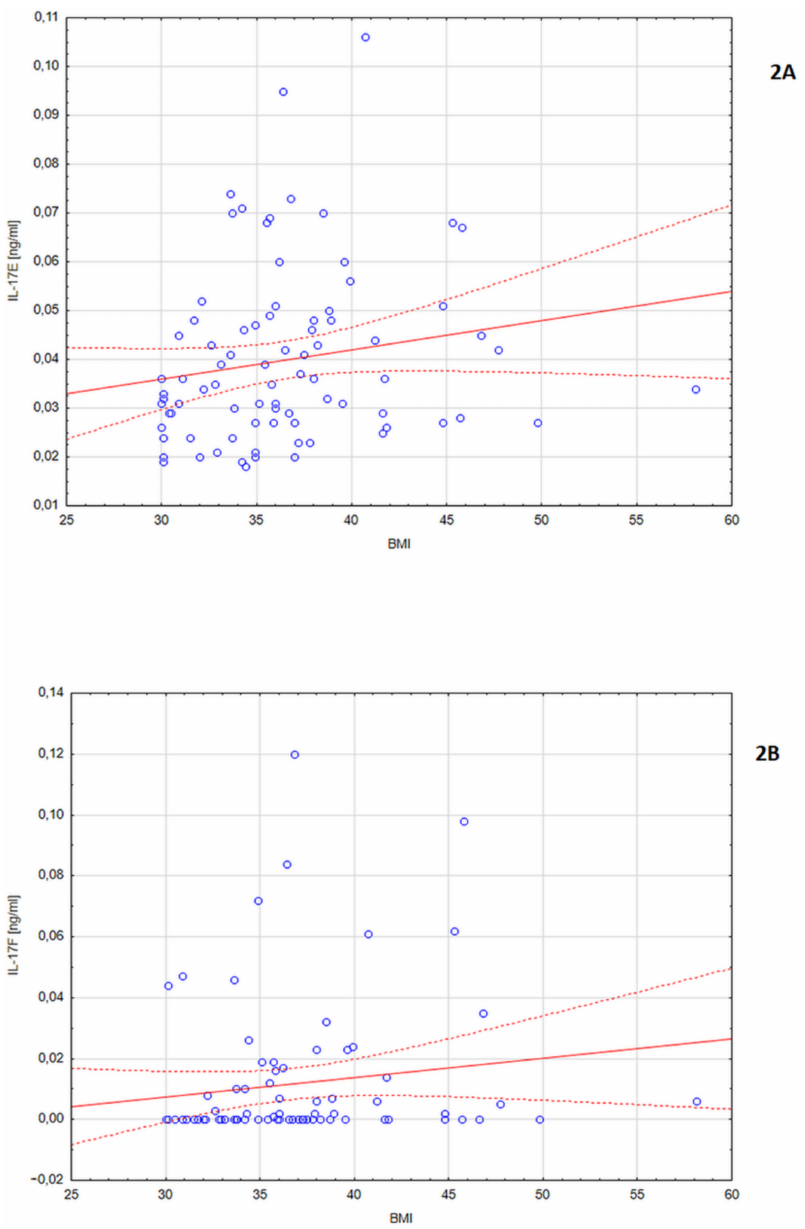
Figure 2. ( A ) Distribution of IL-17E values depending on the BMI level (r = 0.24, p = 0.026); ( B ) distri- bution of IL-17F values depending on the BMI level (r = 0.25, p = 0.025). The level of IL-17E was also higher in the case of a high content of adipose tissue in the right leg, expressed in % (r = 0.25, p = 0.023) and in kg (r = 0.22, p = 0.043) (Supplementary Table S1). Subjects diagnosed with atherosclerosis ( p = 0.04) and taking beta-blockers ( p = 0.024) had higher levels of IL-17F (Figure